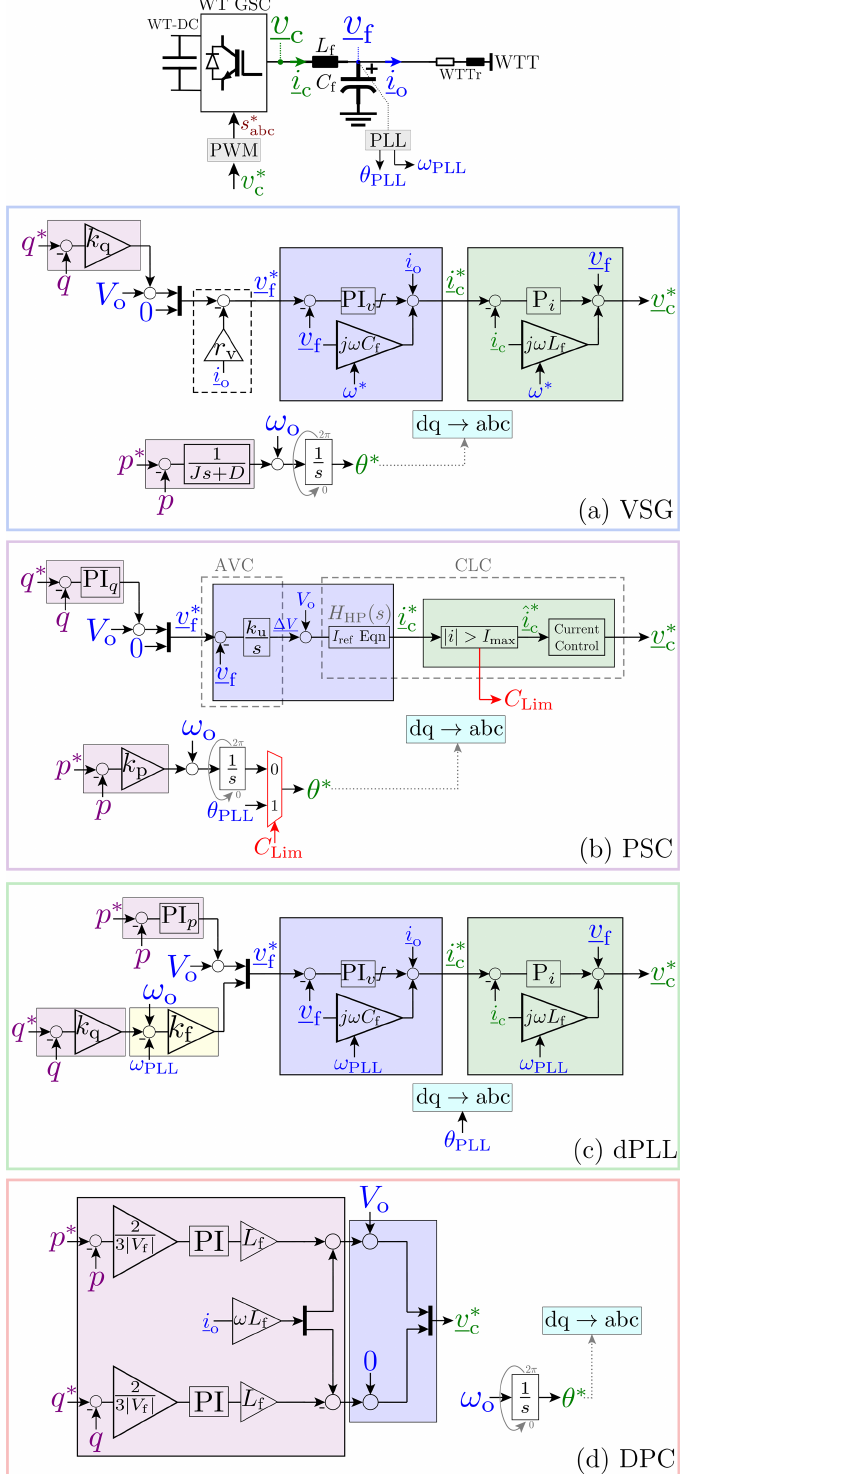
Figure 2. Control structure for (a) virtual synchronous generator (VSG), (b) power synchronization control (PSC), (c) distributed PLL-based (dPLL) control, and (d) direct power control (DPC) GFM strategies. The coloured boxes match the different blocks with their function (blue is voltage control, green is current control, and purple is power control) in the general GFM control structure, given in Fig.